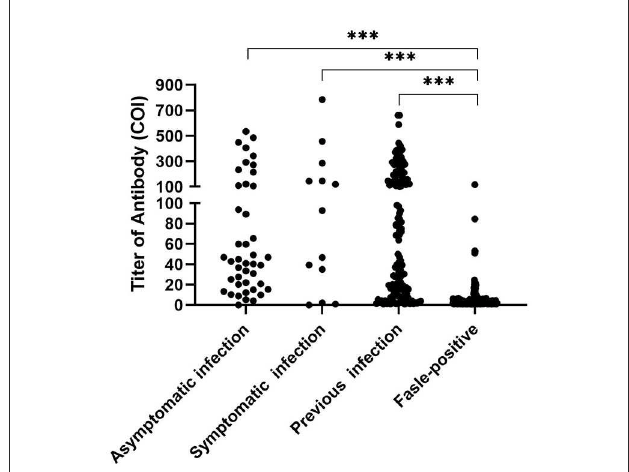
FIGURE3 The titer of anti-SARS-CoV-2 antibody. Statistically significant differences correspond to the differences in the antibody titer between the false-positive group and the other groups. Abbreviations: COI, cut-off index. *** p <